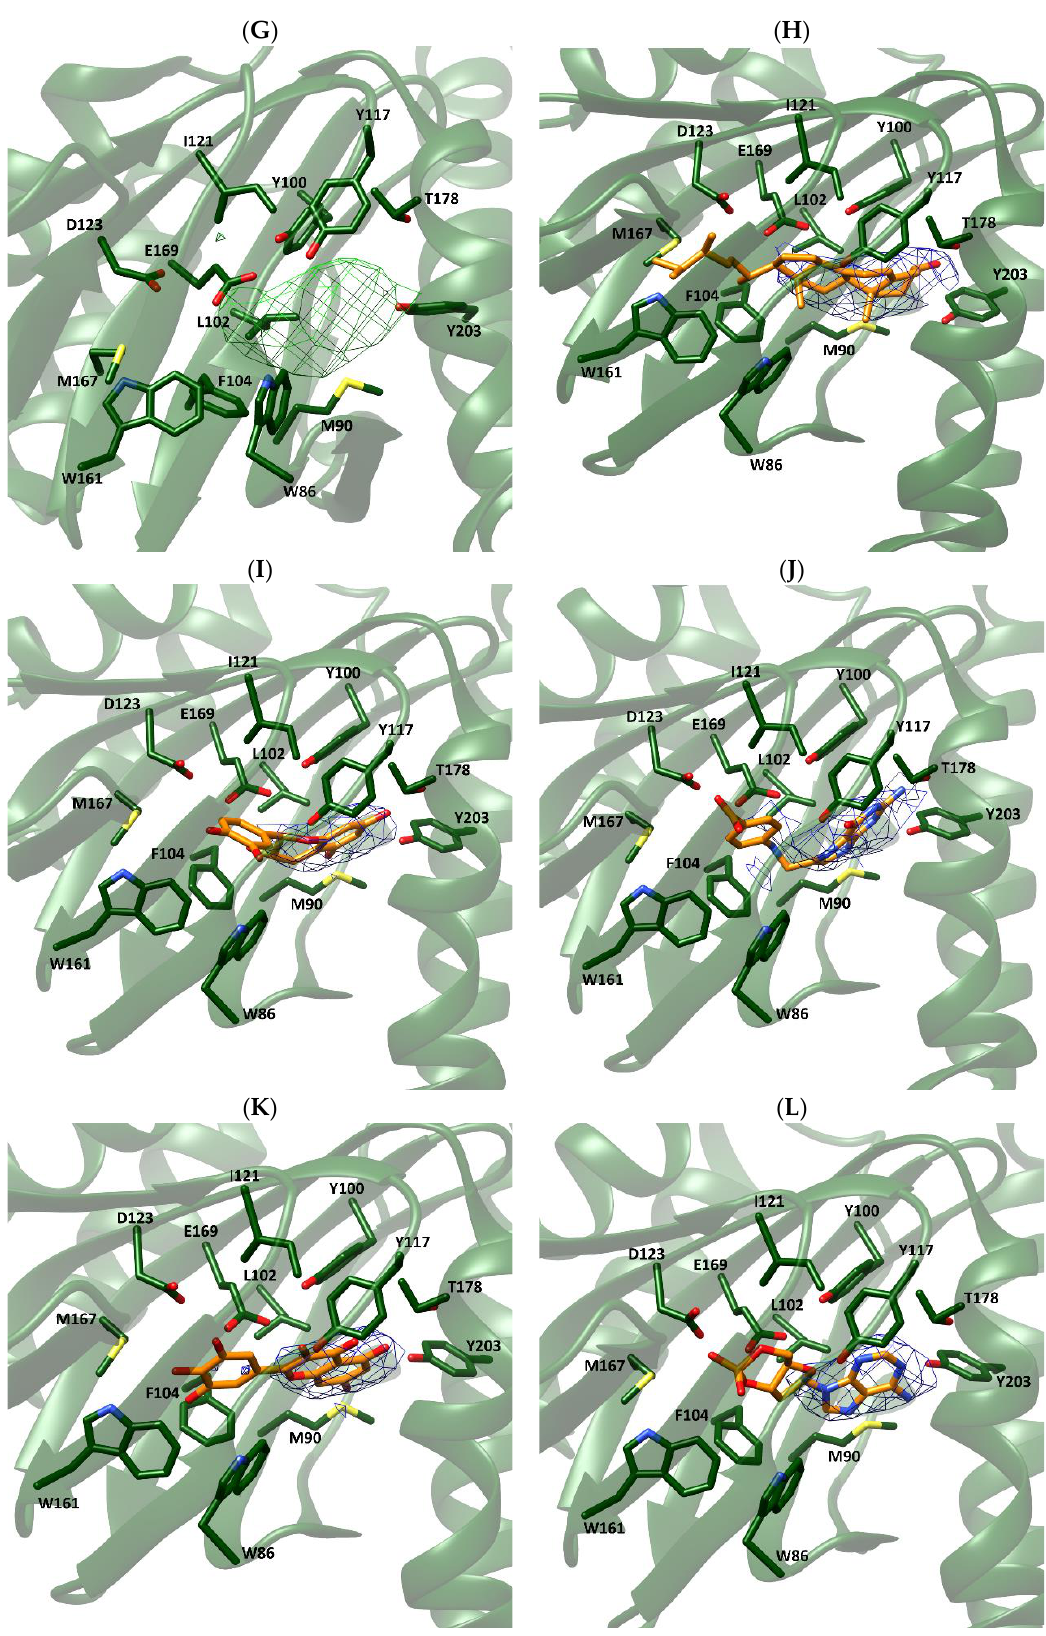
Figure 4. Fitting of selected compounds into the electron density within the ligand binding site of Xl σ 1-R. The protein is shown as ribbon and colored green. The side-chains of residues surrounding